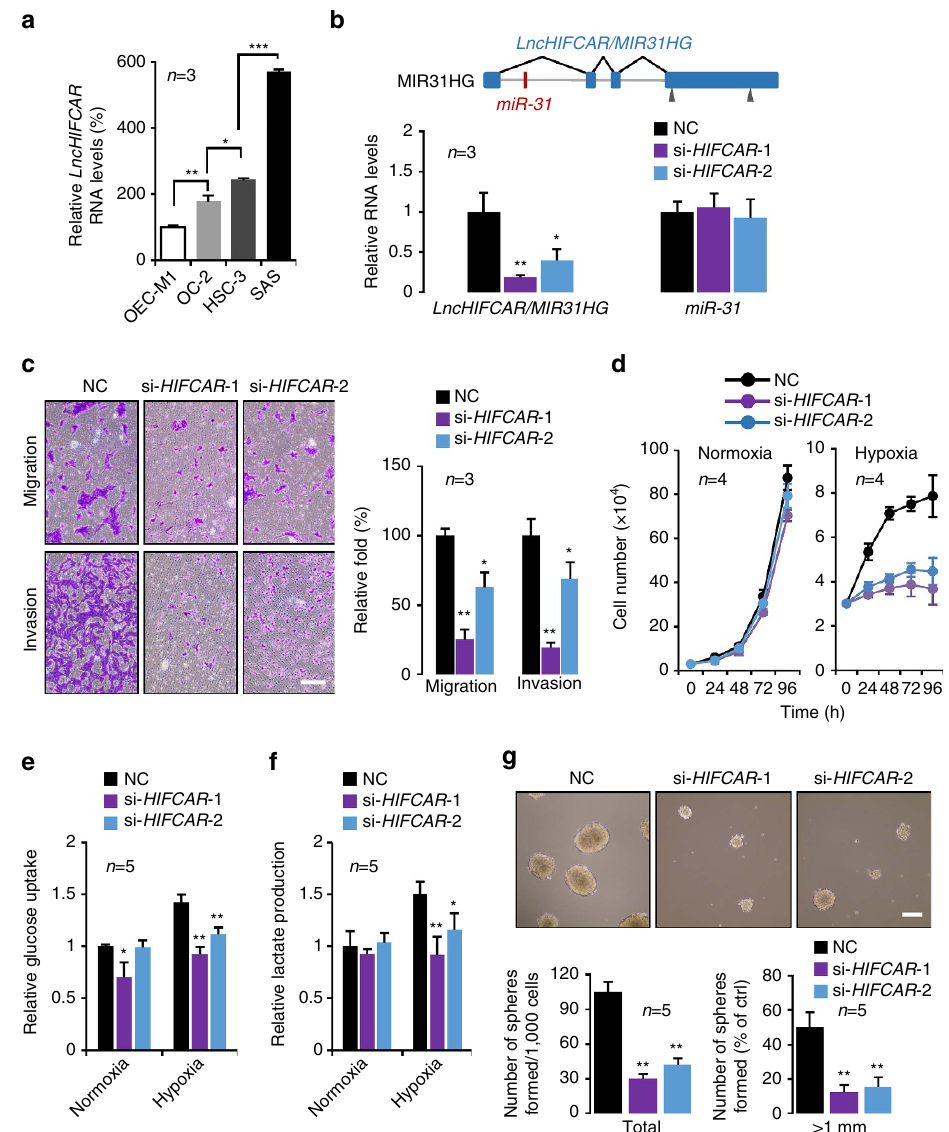
Figure 2 | LncHIFCAR functions as an oncogene driving oral cancer progression. ( a ) Expression levels of LncHIFCAR in oral cancer cell lines. The levels of LncHIFCAR were normalized against RPLP0 mRNA level and are presented relative to the expression in OEC-M1. ( b ) Establishment of LncHIFCAR - knockdown SAS clones. Upper panel: schematic representation of the genomic structure of LncHIFCAR/MIR31HG . The targeting sites of the designed siRNAs are indicated by gray arrowhead. LncHIFCAR/MIR31HG is composed of four exons (filled blue boxes) and the miR-31, located within intron 1, is shown with a red horizontal bar. Lower panel: LncHIFCAR and miR-31 expression levels in siRNA-transfected SAS cells were analysed by qPCR and normalized to GAPDH and U6 level, respectively. ( c ) LncHIFCAR promotes oral cancer cell invasion and migration. Transwell invasion and migration assays of siRNA-transfected SAS cells were performed. Representative photos and quantitative analysis are shown. Scale bar, 100 m m. ( d ) Cell growth curve of the siRNA-transfected SAS cells under normoxia or hypoxia. ( e , f ) Knockdown of LncHIFCAR reduces hypoxia-induced glucose uptake ( e ) and lactate production ( f ). The glucose and lactate levels in the culture media of the siRNA-transfected SAS cells were measured after 16h of normoxia or hypoxia treatment. The data are presented as fold difference compared with the level of negative control siRNA-transfected cells in normoxia. ( g ) Knockdown of LncHIFCAR reduces the sphere-forming ability of SAS cells. The siRNA-transfected SAS cells were grown in suspension culture to form sphere. Representative phase- contrast microscopic images of the cell aggregates are displayed (scale bar, 300 m m). Bar graph represents the total number of spheres or the relative number of spheres with diameter 4 1mm. Graphs show mean ± s.d. NC, negative control. n , the number of independent experiments performed; Student’s t -test, * P o 0.05, ** P o 0.01 and *** P o 0.001.